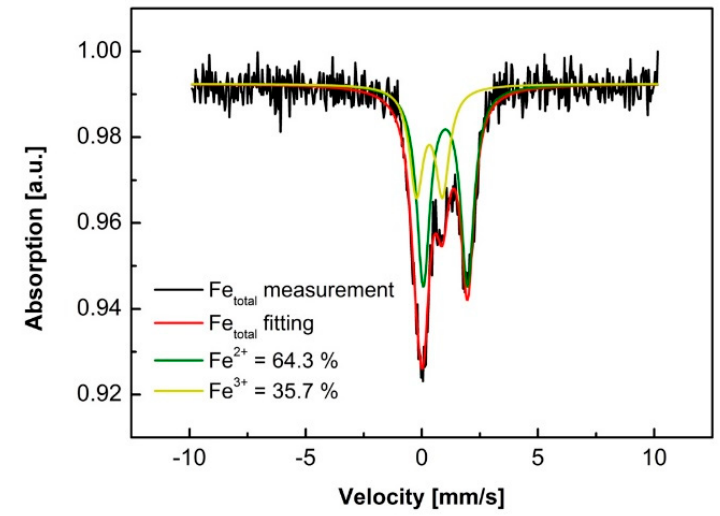
Figure 1. 57 Fe resonant absorption Mössbauer spectra of IRI5 basalt fiber sample (iron redox index = 0.64).